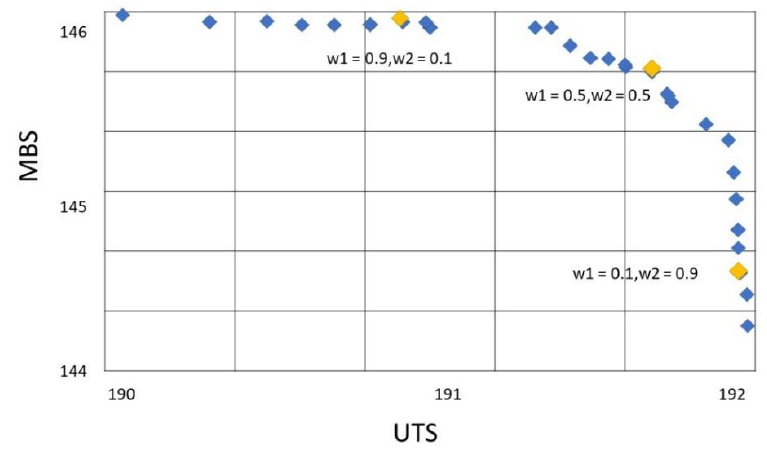
Figure 5. Pareto front of DE.